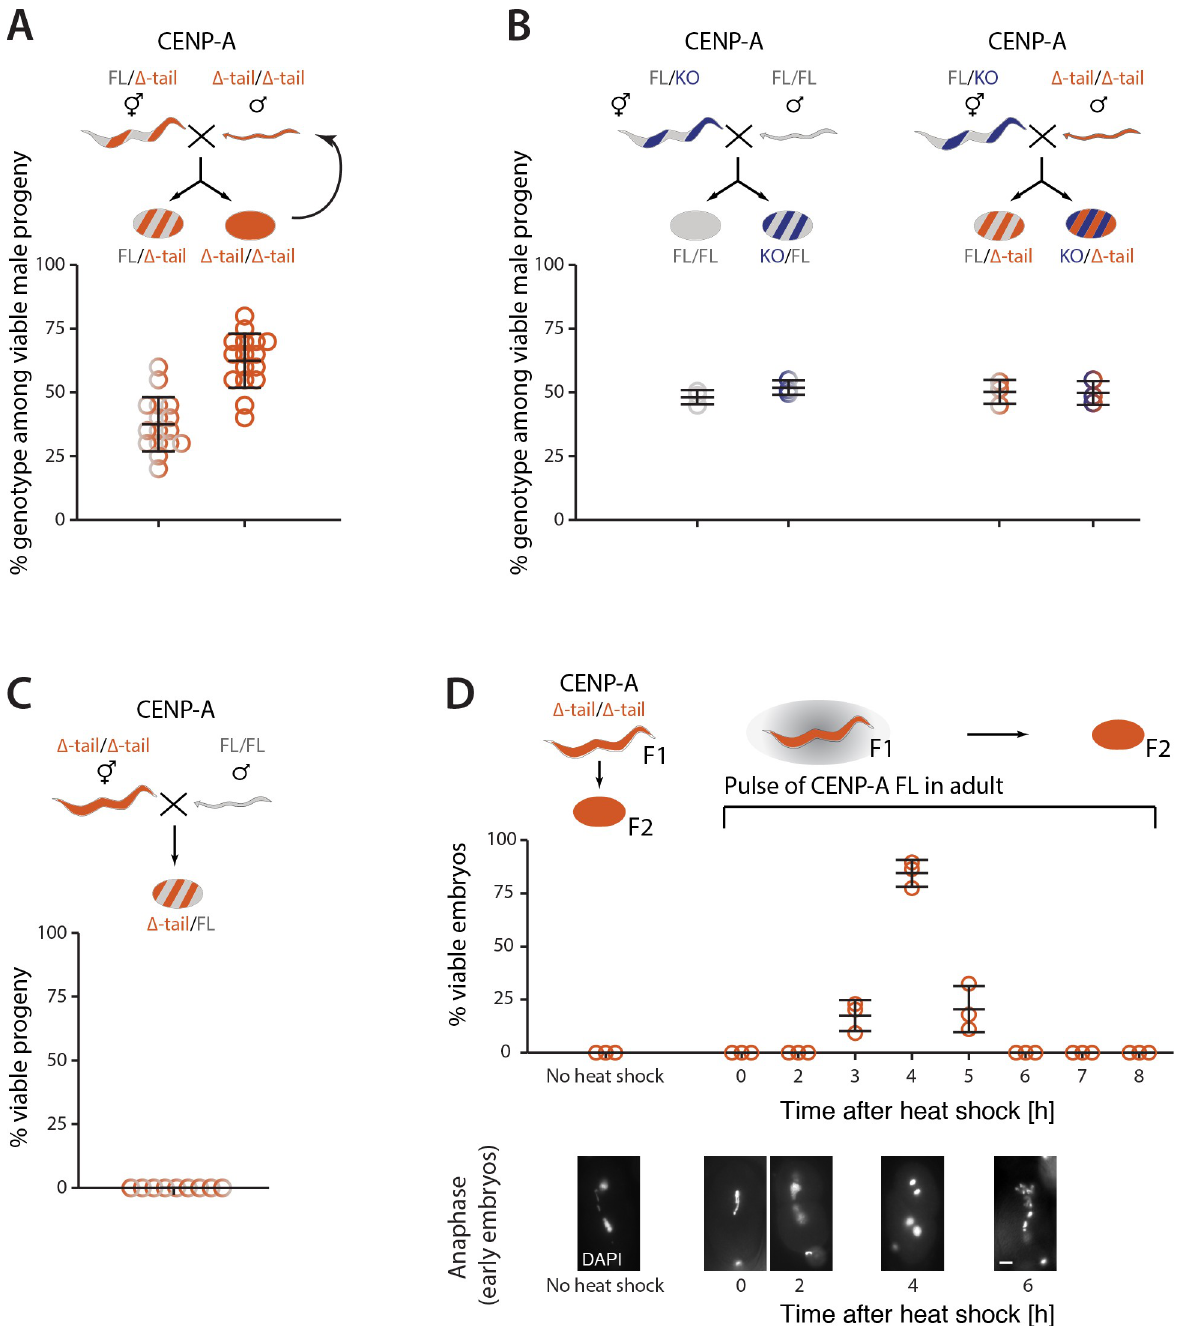
Fig 4. The CENP-A N-terminal tail is required for establishing centromere identity in the germ line. Cartoons showing the different CENP-A genotypes (FL, gray; KO, dark blue; Δ -tail, orange) as heterozygotes (striped) or homozygotes (full). (A) Maintenance of CENP-A Δ -tail homozygous males by crossing. Percentage CENP-A Δ -tail hetero- and homozygotes among viable male cross-progeny after crossing CENP-A Δ - tail homozygous males with heterozygous CENP-A FL/ Δ -tail hermaphrodites. N = 16 independent crosses. (B) Rescue of embryonic lethality of CENP-A KO embryos by zygotic expression of CENP-A FL (left) or Δ -tail (right), introduced by genetic crosses of CENP-A FL or Δ -tail homozygous males to heterozygous CENP-A KO hermaphrodites. Percentages of viable progeny for each genotype are shown. N = 3 independent crosses each. (C) Non-rescue of embryonic lethality of CENP-A Δ -tail F2 embryos by zygotic expression of CENP-A FL, introduced by genetic crossing of wild-type males to homozygous CENP-A Δ -tail F1 hermaphrodites. Percentage of viable progeny is shown. N = 9 independent crosses. (D) Rescue of the embryonic lethality of CENP-A Δ -tail F2 embryos by pulse of CENP-A FL protein expression in F1 adults. (D) Percentage of viable F2 embryos without heat shock and at different time points 0–8 h after heat shock–induced expression of CENP-A FL protein in adult F1